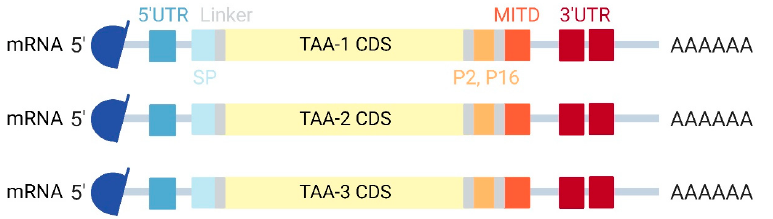
Figure 8. Design for TAA mRNA. Abbreviations: SP, signal peptide; P2 and P16, the tetanus toxoid CD4 + epitopes P2 and P16; MITD, major histocompatibility complex class I; linker, glycine/serine linker.